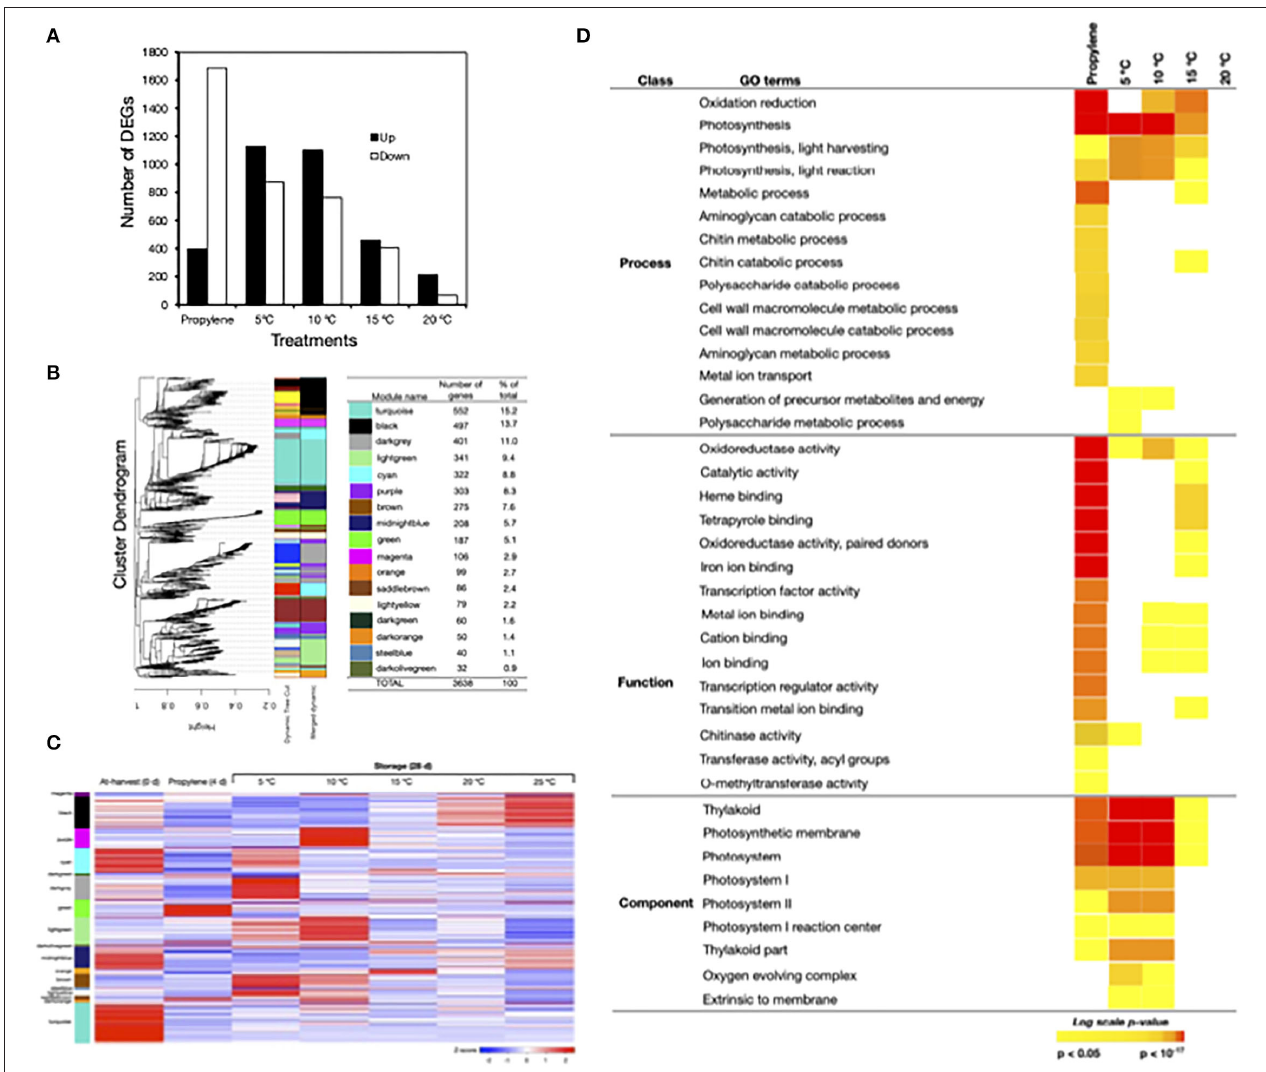
FIGURE 4 | Transcriptomic changes in the flavedo of Satsuma mandarin fruit in response to propylene and different storage temperatures. (A) Number of genes that were differentially expressed in response to propylene treatment and storage at 5 ◦ C, 10 ◦ C, 15 ◦ C, and 20 ◦ C. Propylene effect was determined using at-harvest (0 days) samples as a control, whereas the control samples for storage temperature tests included fruit at 25 ◦ C. (B) Weighted gene coexpression network analysis (WGCNA) of differentially expressed genes (DEGs) identified from the flavedo of Satsuma mandarin fruit treated with propylene or stored at different temperatures. The left panel shows the cluster dendrogram with the major tree branches. The right panel shows the different colors assigned to each one of the 17 modules obtained after implementing the tree cut line (0.15) to merge close modules and the number of genes in each module. (C) Heatmap showing the expression measures of genes in each WCGNA module at harvest (0 days), after 4 days propylene treatment and 28 days storage at the specified temperatures. (D) Selected gene ontology (GO) terms that were enriched among the DEGs that responded to propylene treatment or storage at 5 ◦ C, 10 ◦ C, and 15 ◦ C. Color panels display the P -values of the respective GO enrichment